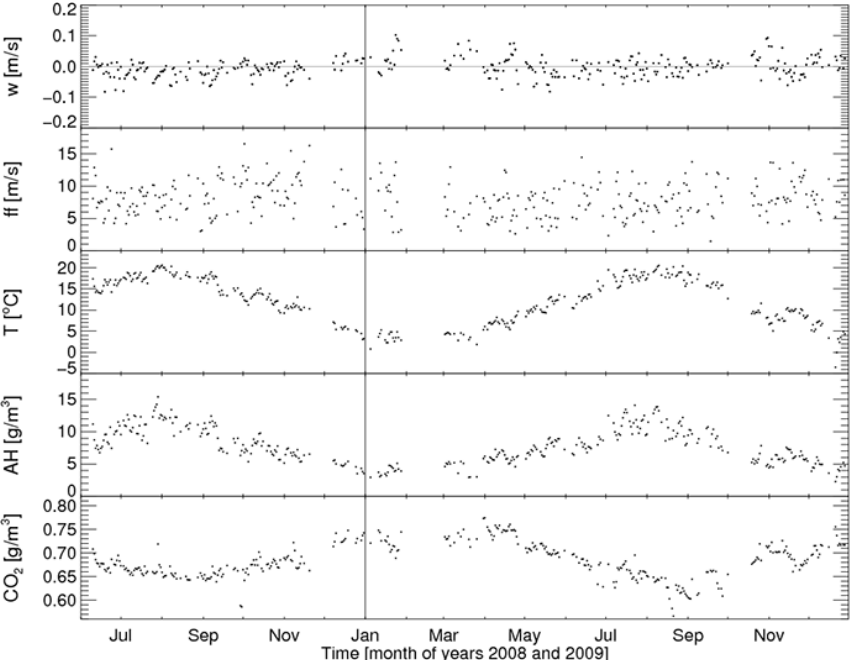
Figure 3. Daily means of measured quantities at a height of 13.8m above sea surface: vertical wind speed ( w ), horizontal wind speed ( ff ), air temperature ( T ), absolute humidity (AH), and CO 2 density from June 2008 to December